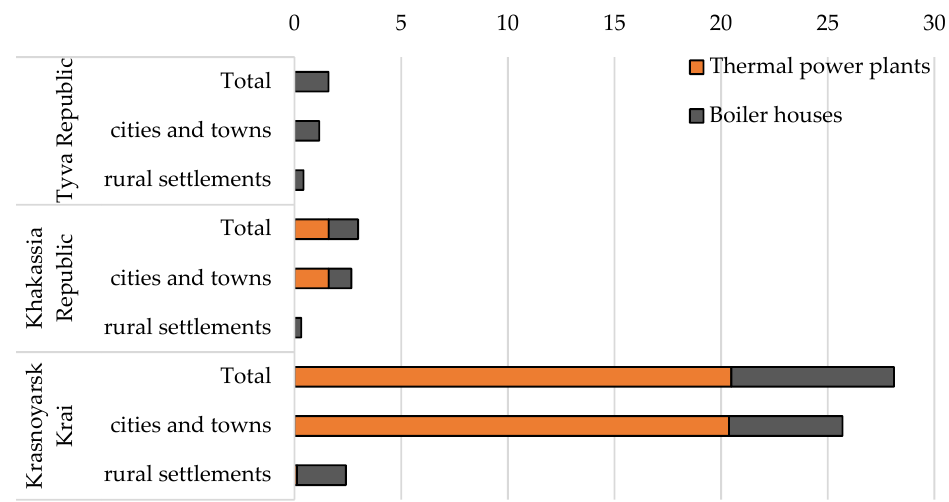
Figure 4. Heat production by the regions of Yenisei, Siberia, in 2021 by heat supply sources, million Gcal. Source: Rosstat data.